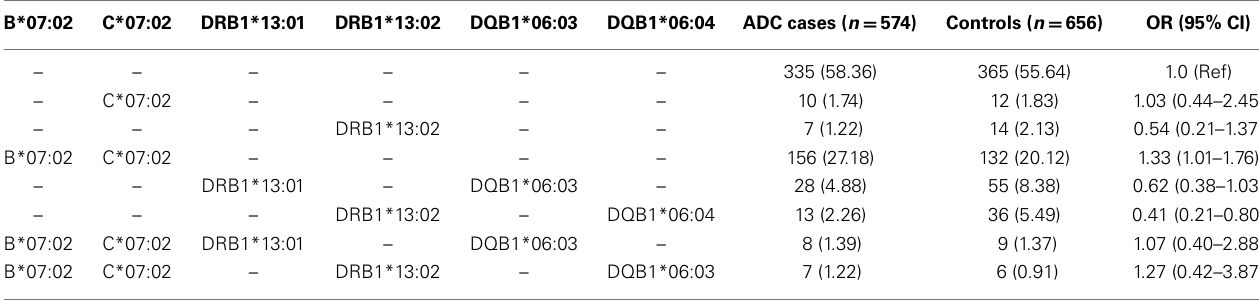
Table 4 |Association between HLA allele combinations and cervical adenocarcinoma among Caucasians and pooledWestern and Eastern US cervical cancer studies